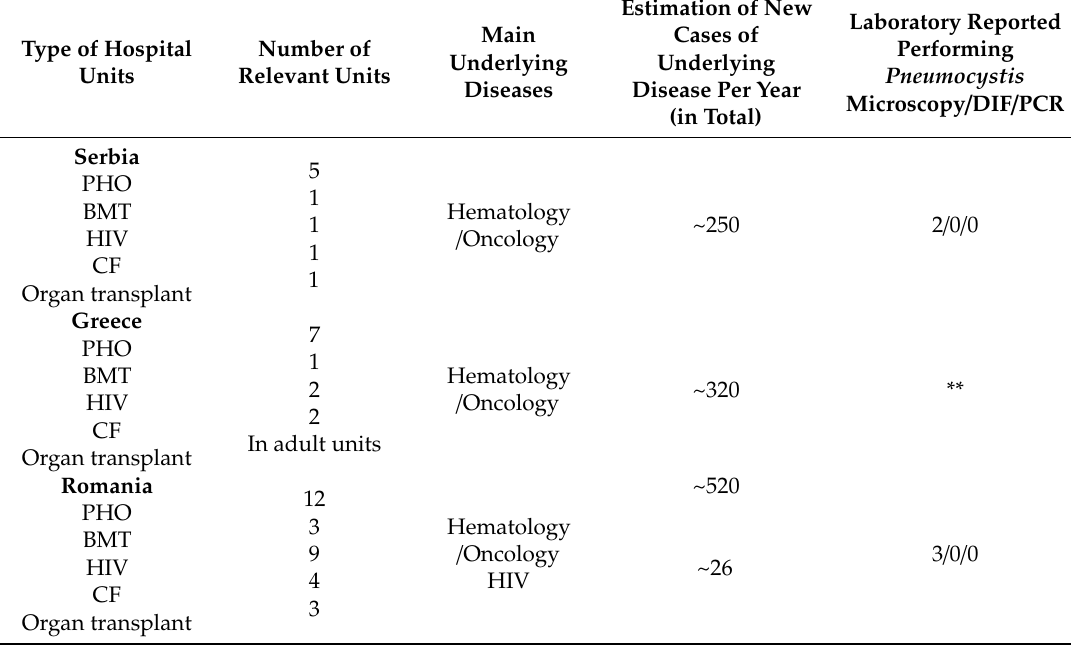
Table 1. Pediatric population (age 0–18) in Serbia (1,214,924), Greece (1,788,782), and Romania (4,170,598) in 2019: types of hospital unit, reported underlining diseases in pediatric population at risk, numbers of new cases at risk and current laboratory practices for Pneumocystis pneumonia